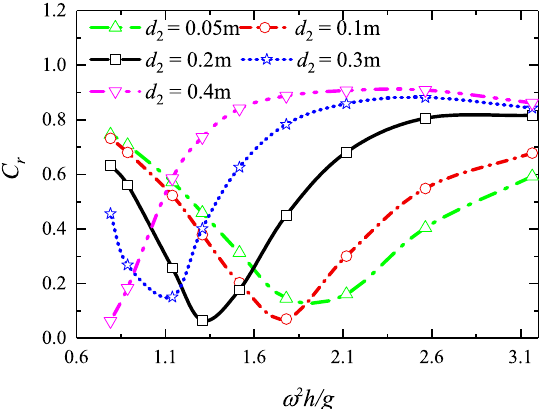
Figure 14. Variation of reflection coefficients versus ω 2 h / g for different draughts d 2 .